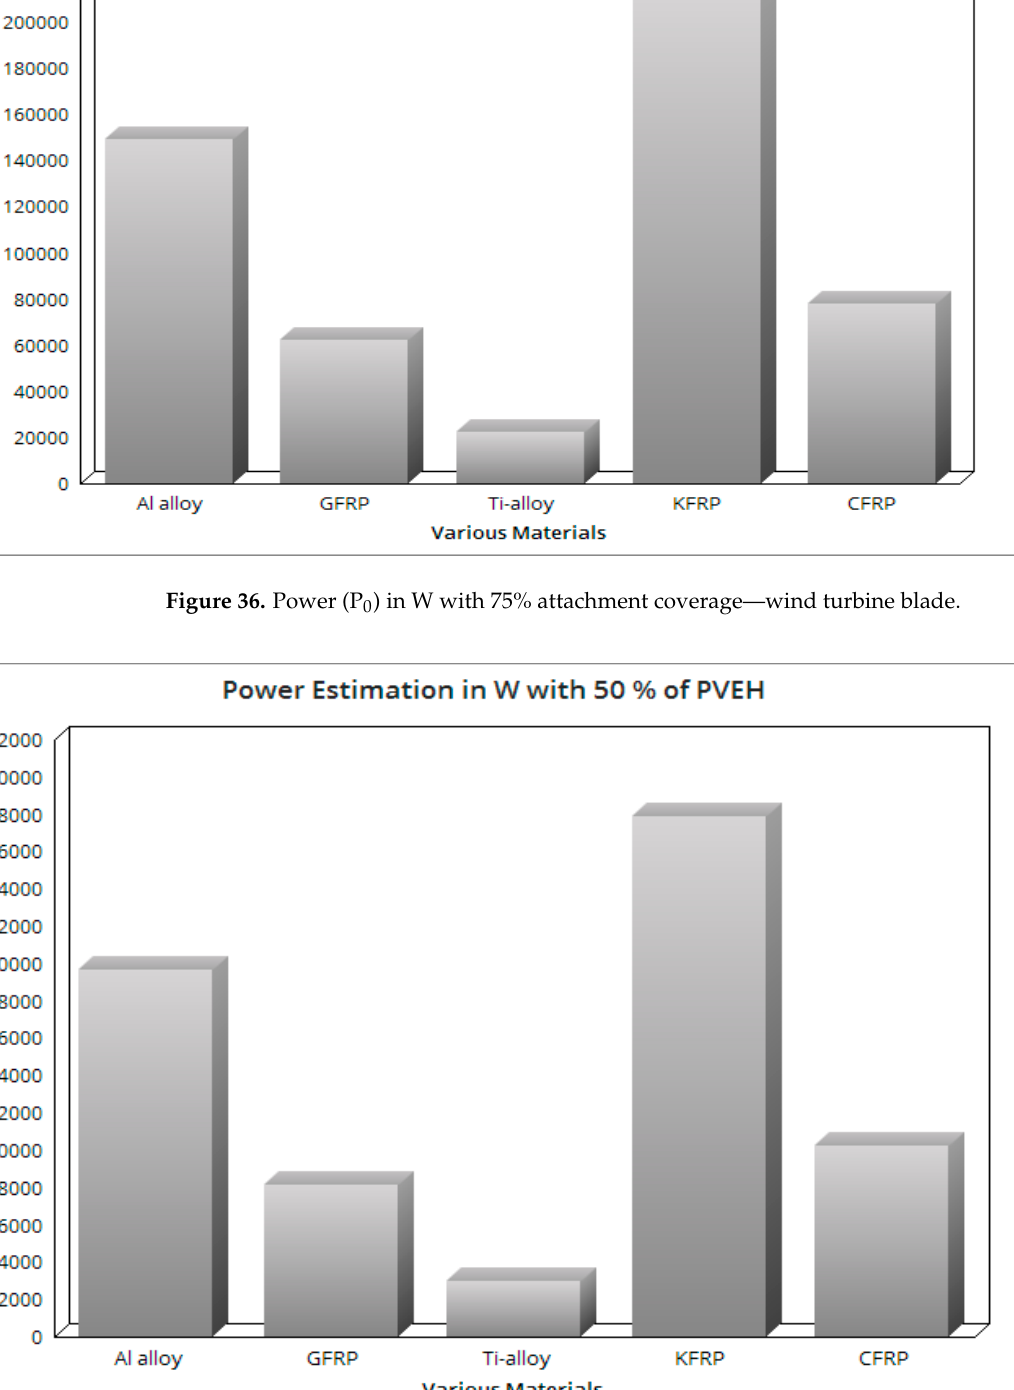
Figure 37. Power (P 0 ) in W with 50% attachment coverage—wind turbine blade.